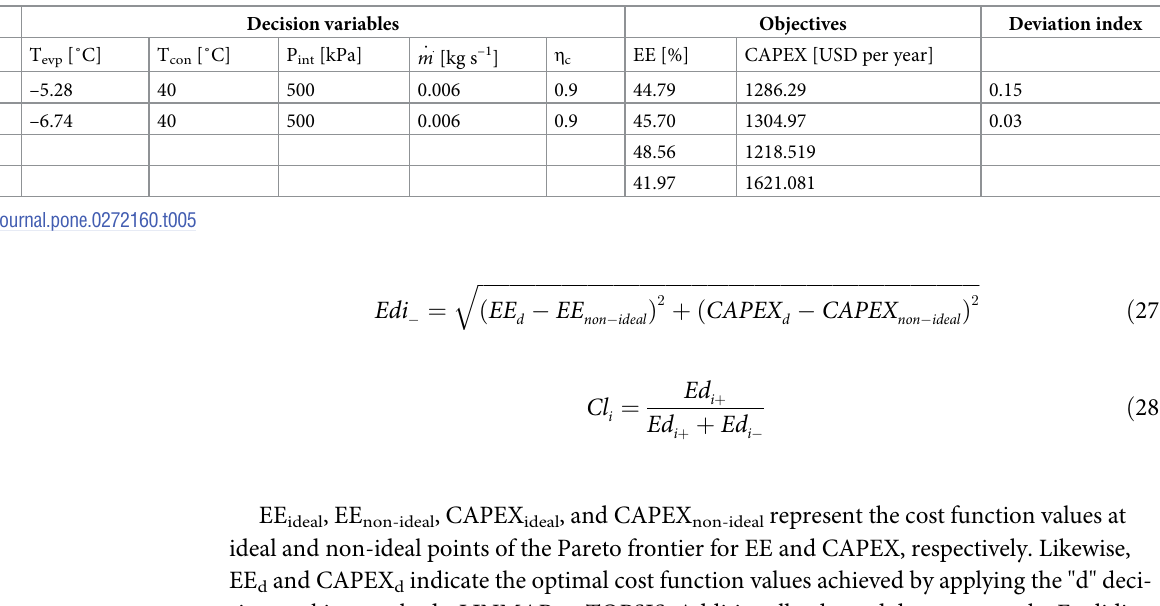
Table 5. Optimal solutions obtained for the first scenario using decision-making methods.